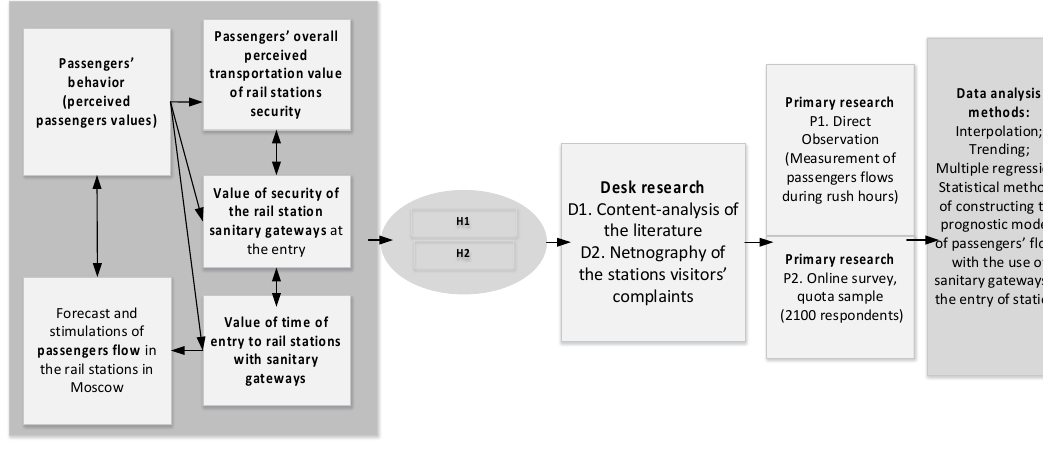
Figure 2. Research study design.